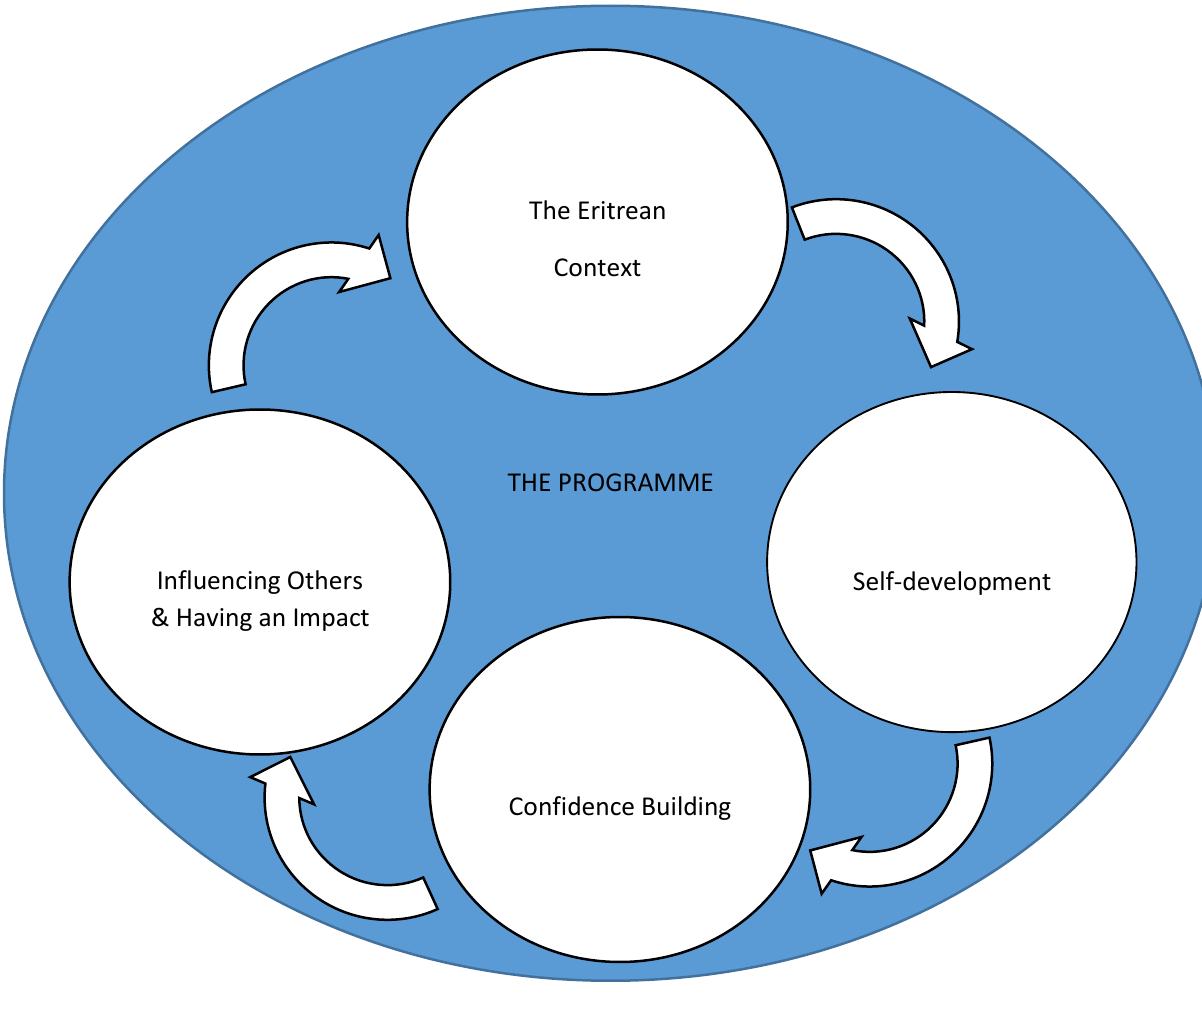
Figure 1 . Conceptual model of emerging